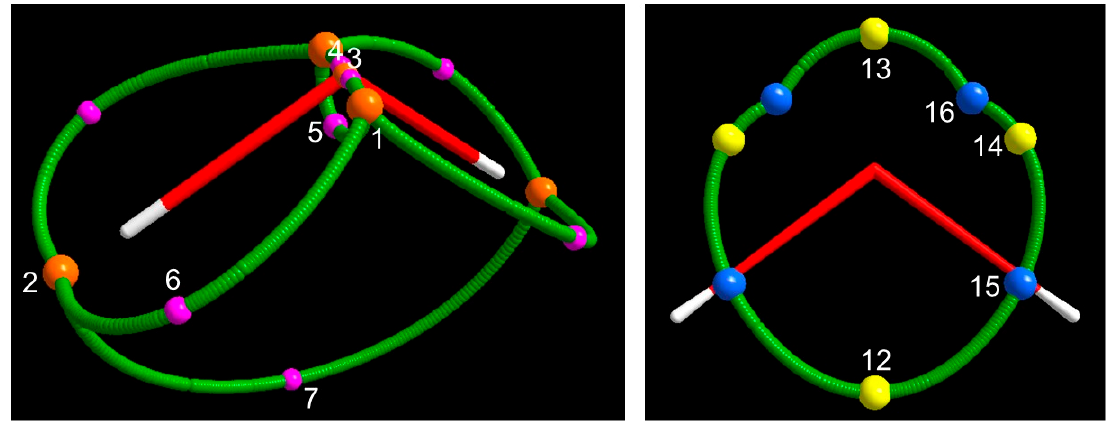
Figure 4. Unrestricted Hartree Fock ( UHF) spin density maxima joining paths: α – α , positive spin density regions (s + , left); β – β , negative spin density regions (s – , right). In both panels, the ∇ ρ bond paths are also shown (from H nucleus to the bcp in white and from bcp to O nucleus in red). For all other details, see the caption of Figure 3.